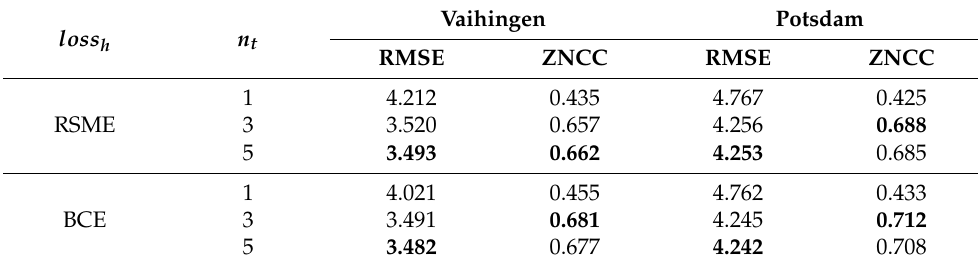
Table 4. Ablation study. Comparison of the number of channels of style distribution maps and the choice of the height regression function. Best results in each category are in